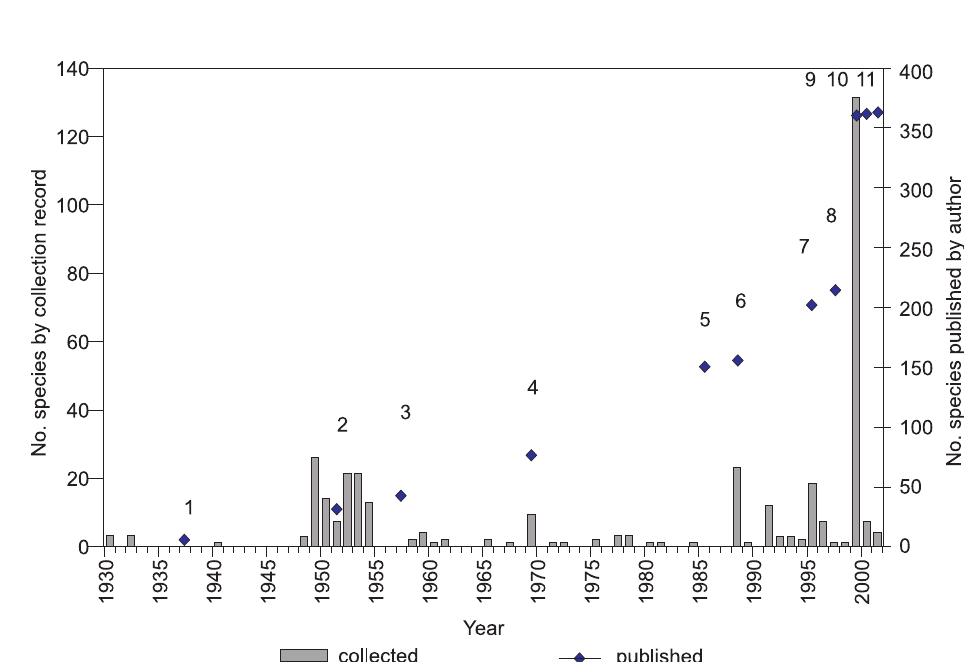
Fig. 1: The number of invasive alien plant species recorded in the Kruger National Park between 1930 and 2001. The list includes species listed according to published and other lists, as well as according to dates of collections/observations of species. For published and other species lists, the authors are indicated: 1. Ober- meijer (1937); 2. Codd (1951); 3. Van der Schijff (1957); 4. Van der Schijff (1969); 5. Gertenbach (1985); 6. Macdonald & Gertenbach (1988); 7. Anon (1995); 8. Anon (1996); 9. Foxcroft (1999); 10. Foxcroft (2000); 11. Foxcroft